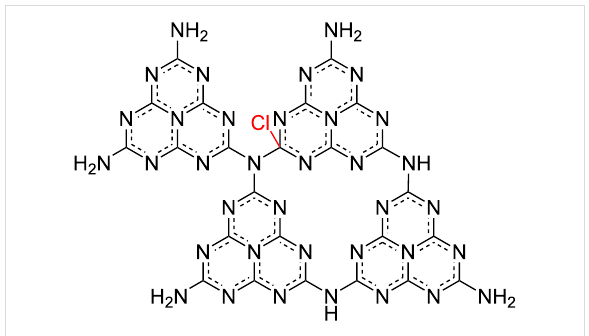
Figure 5: Structure of chlorine-doped polymeric carbon nitride.